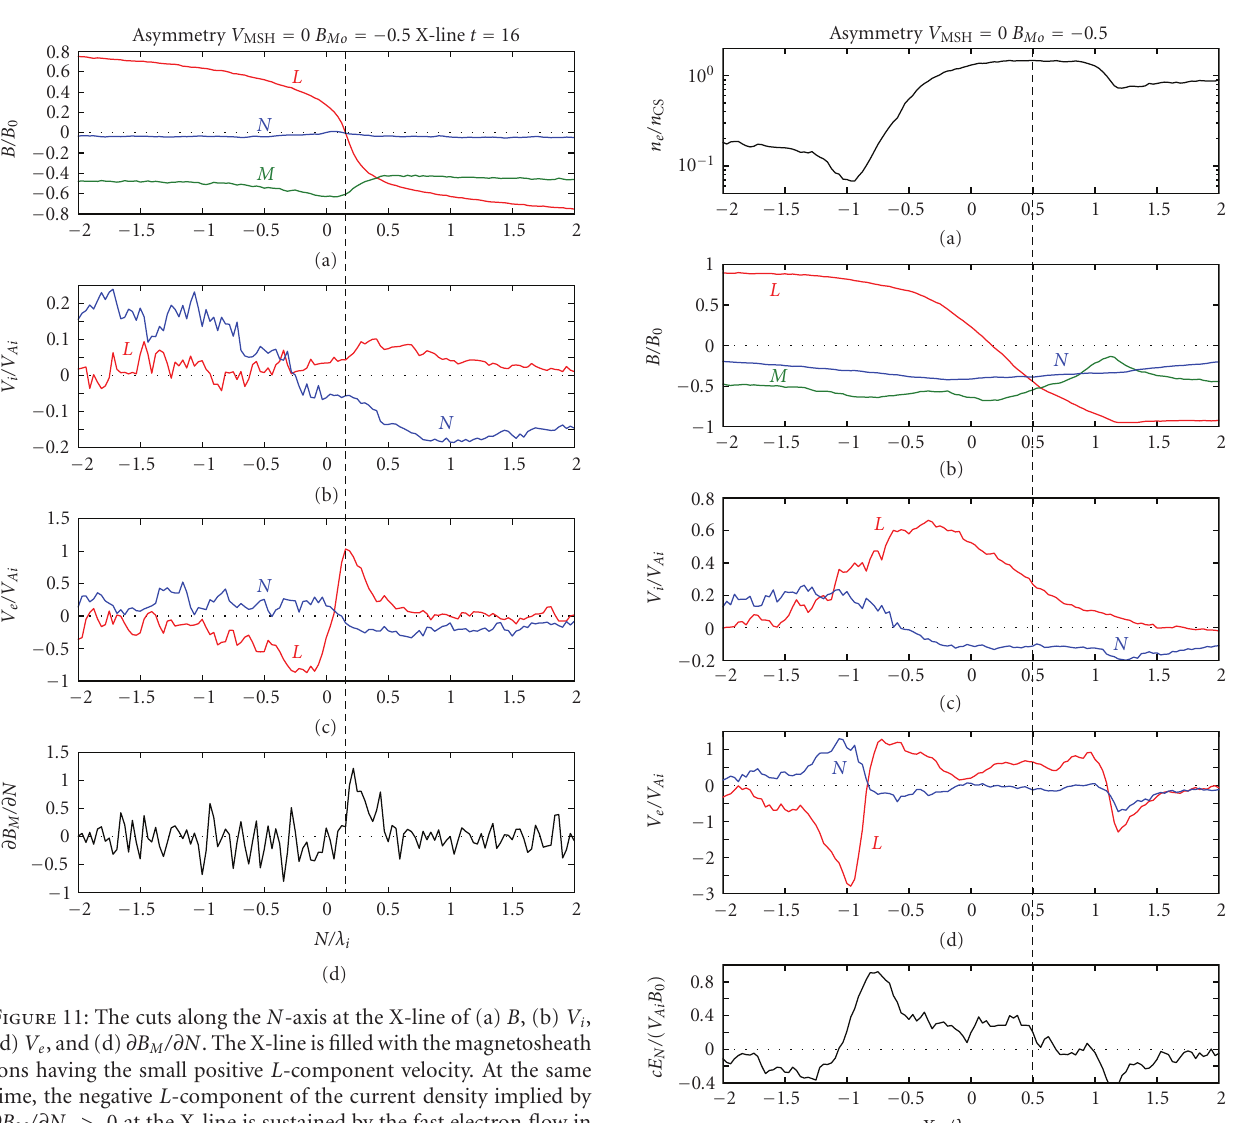
Figure 11: The cuts along the N -axis at the X-line of (a) B , (b) V i , (d) V e , and (d) ∂B M /∂N . The X-line is filled with the magnetosheath ions having the small positive L -component velocity. At the same time, the negative L -component of the current density implied by ∂B M /∂N > 0 at the X-line is sustained by the fast electron flow in the positive- L direction.